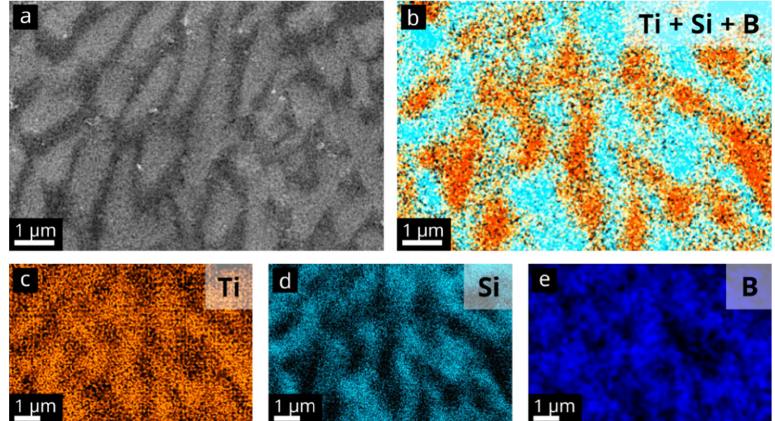
Figure 6. SEM and EDS mapping analysis of selective laser melted TiB 2 -Si Cylinder 3 (2200 mA laser current): ( a ) SEM morphology, and ( b – e ) is the TiB 2 -Si-B map (TiB 2 is marked by orange, Si by blue, top view).